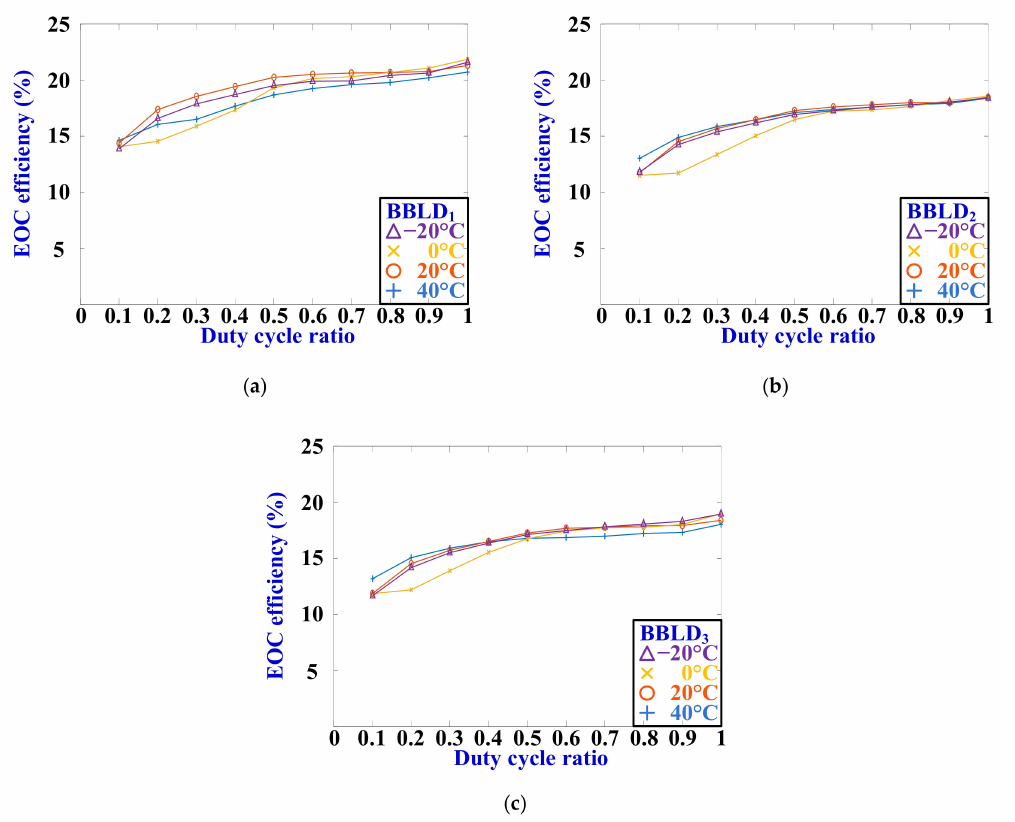
Figure 18. EOC e ffi ciency using electrical power RMS value calculation ( f s = 250 Hz). ( a ) BBLD 1 . ( b ) BBLD 2 . ( c ) BBLD 3 .